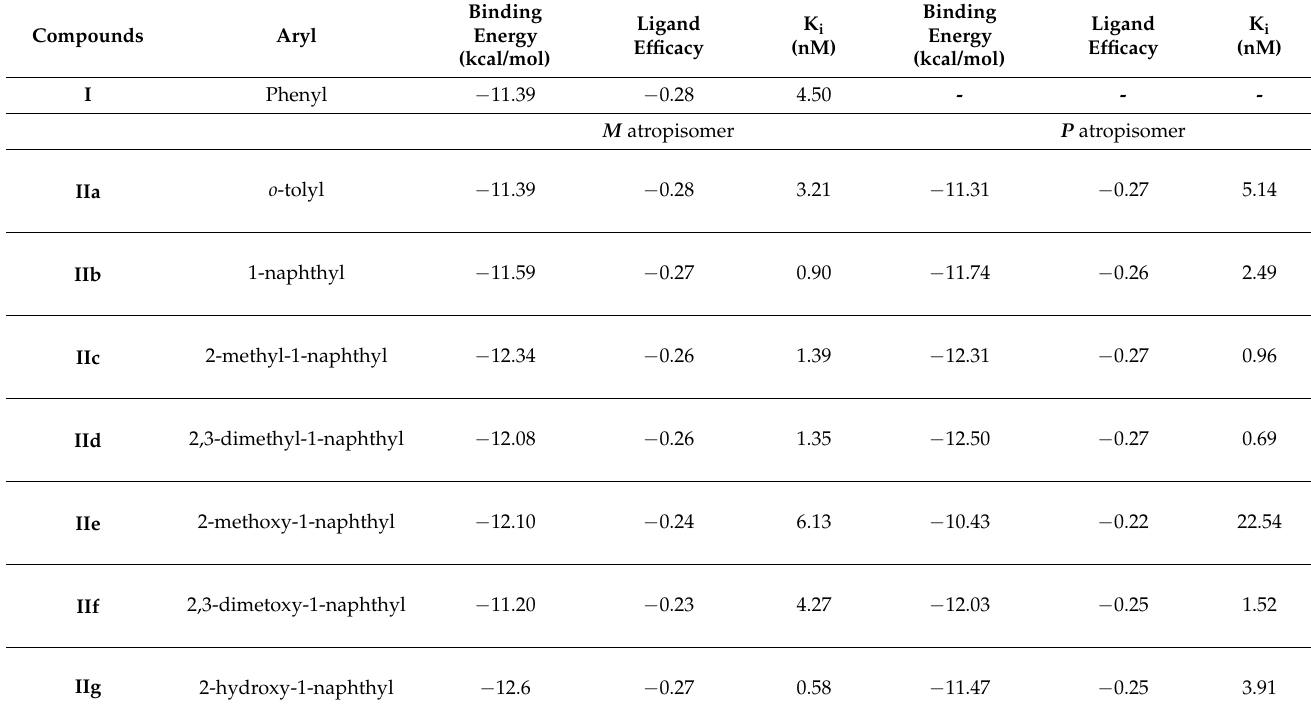
Table 2. AutoDock4.2 docking calculation on 1HWK enzyme with atropostatins II